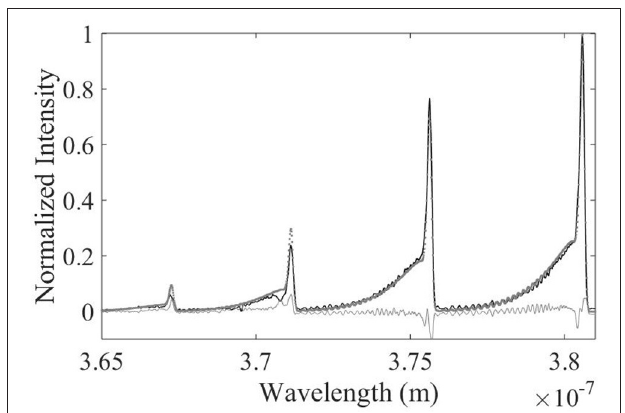
FIGURE 2 | An example rovibrational spectrum with corresponding fitted spectrum for a 60 W, 1.5 Torr N 2 plasma, giving a gas temperature estimate of 547 ± 20 K. The experimental data is shown as a solid black line, the simulated spectrum is overlayed as gray dots. The error between the experimental and simulated spectra is shown as a thin gray line as an indication to the quality of the fit.